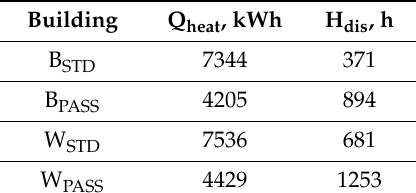
Table 5. Heating demand and thermal discomfort in the whole building.